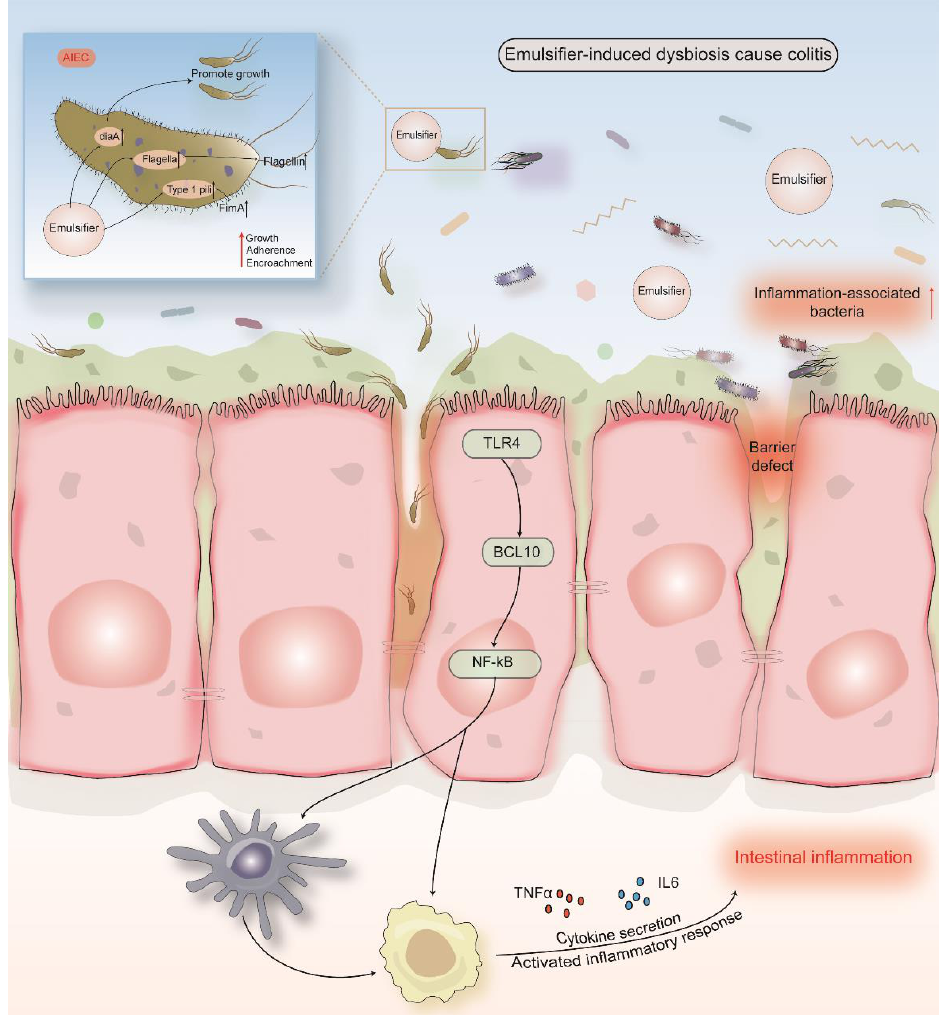
Figure 2. Mechanism of emulsifier-induced colitis via gut microbiome. Emulsifiers (1) altered the growth and functions of AIEC, resulting in the activation of inflammatory pathways in the epithelium; (2) enhanced the abundance of inflammation-related bacteria; (3) destroyed the mucosal barrier. “ ↑ ” means an increased level.